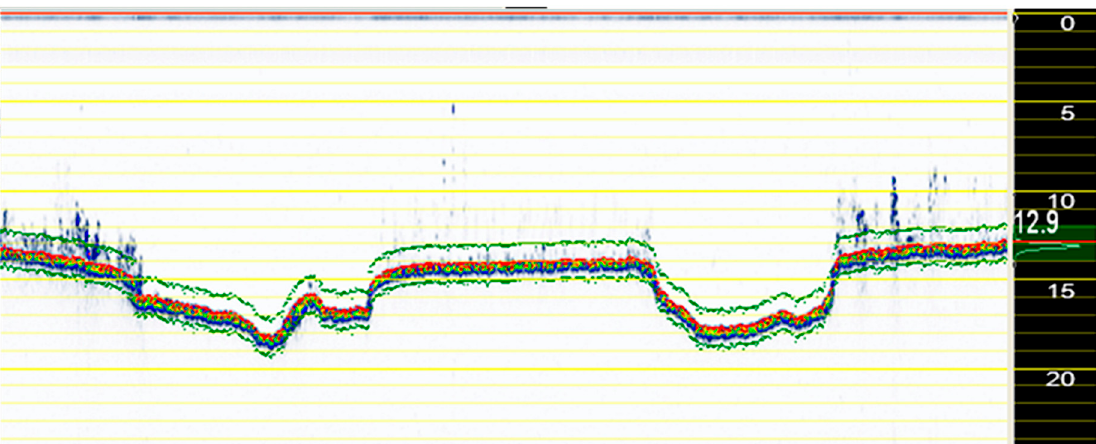
Figure 4. Example raw sonar data from Odom eChart software for a survey line showing a channel on the left side. The bottom shows as multiple sonar returns with significant noise.